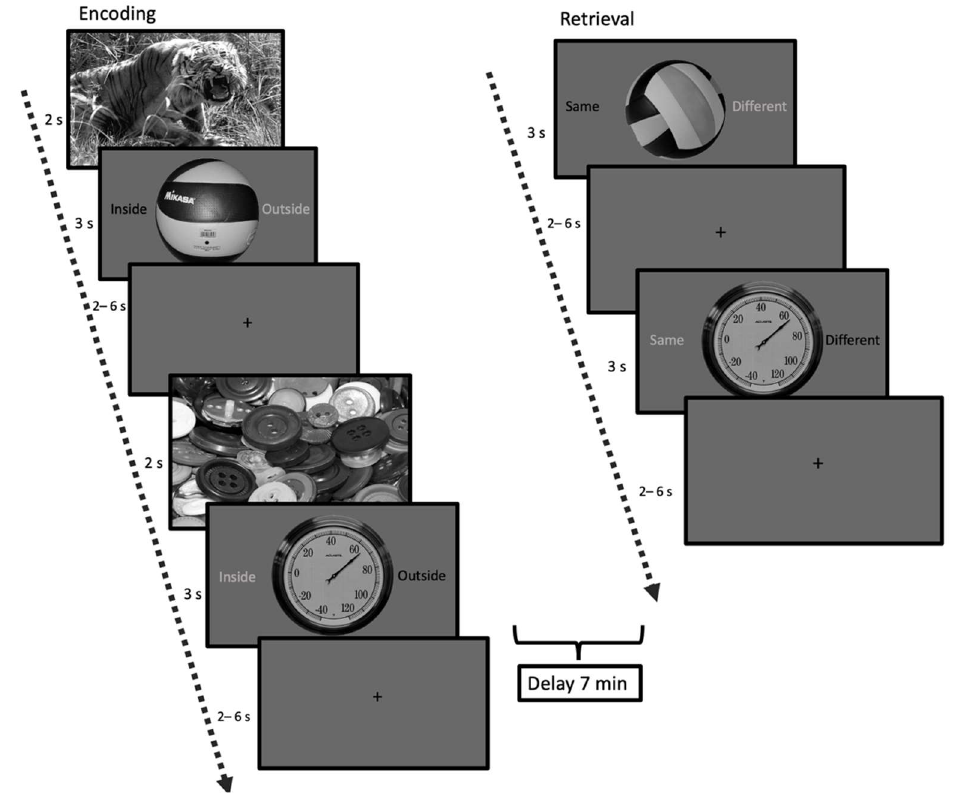
Figure 1. Schematic representation of the mnemonic discrimination task. Encoding consisted of 100 everyday objects shown in either a high (e.g., tiger) or low (e.g., buttons) arousing context. After a 7-min resting-state period participants were asked to indicate if the item was the same or different as seen during the encoding phase (retrieval phase).